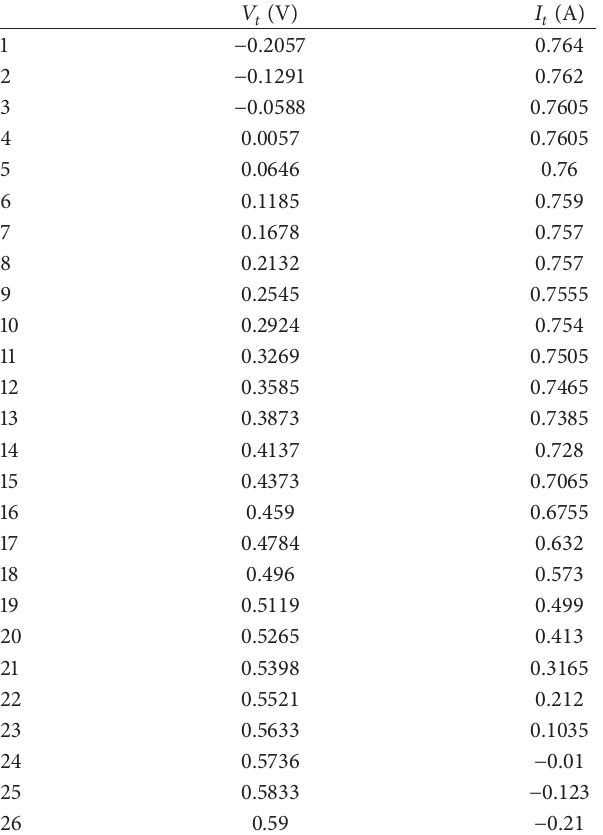
Table 6: The 𝐼 - 𝑉 data of the solar cell, RTC France.